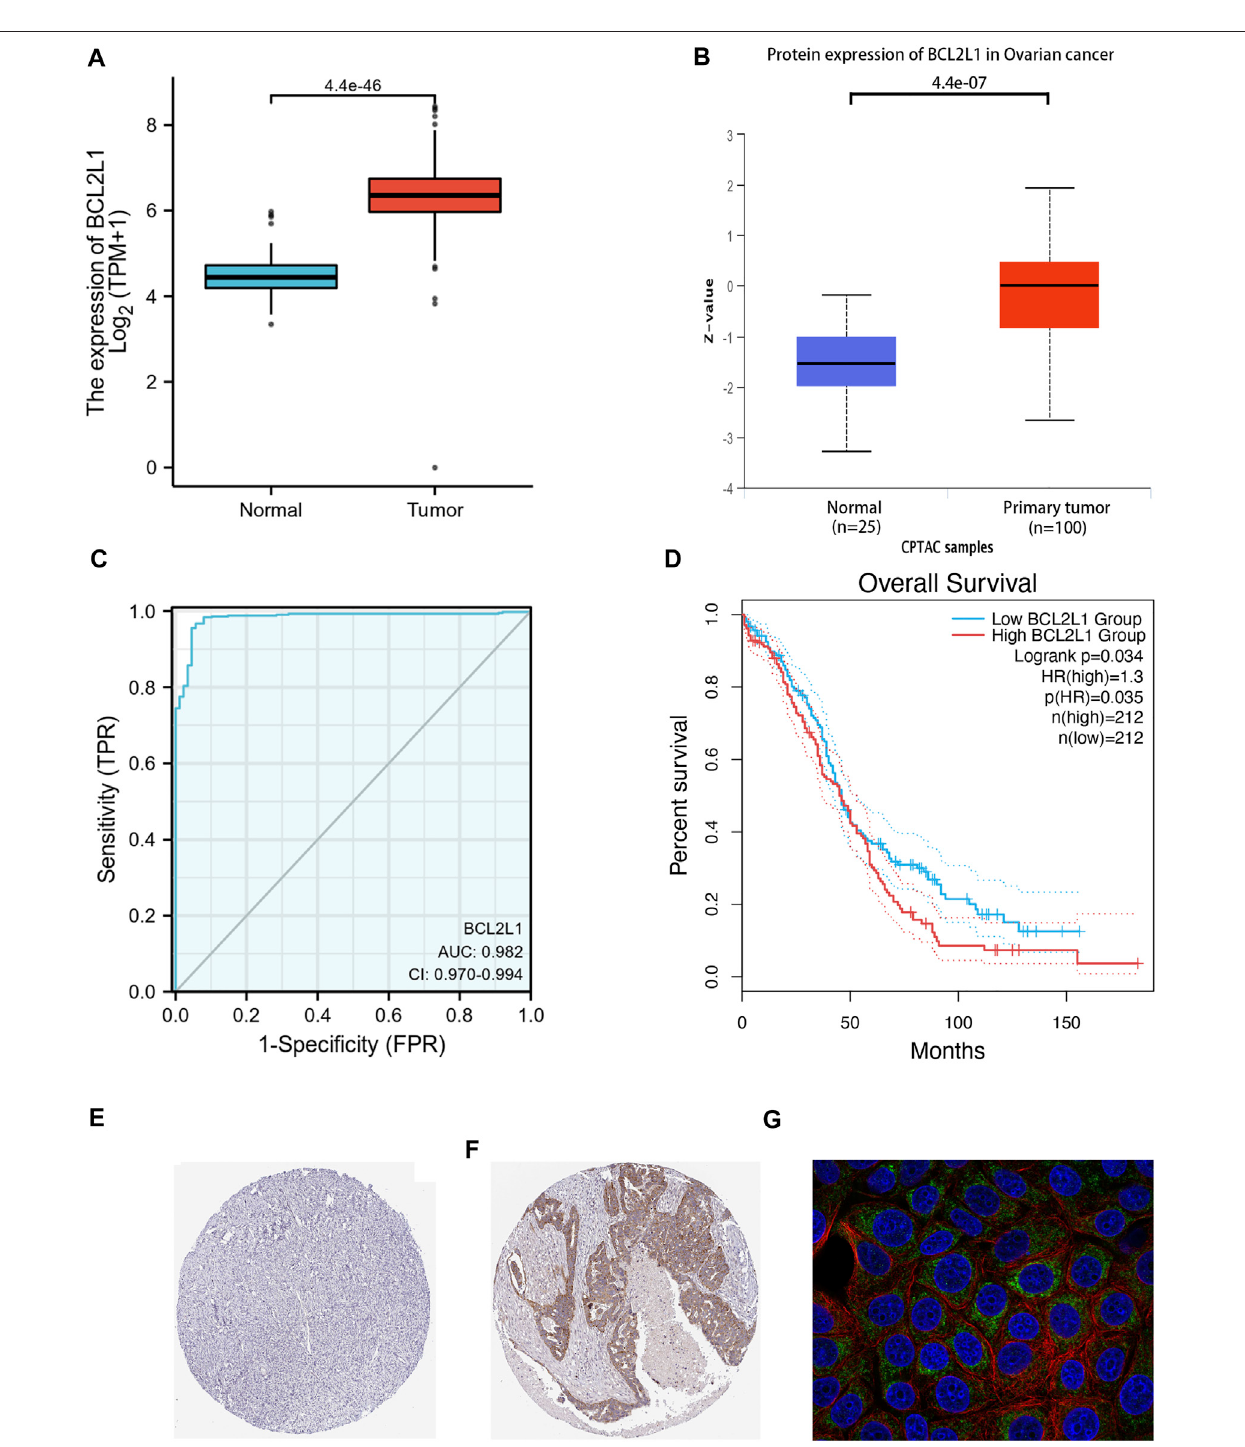
FIGURE6| BCL2L1ishighlyexpressedinOCandcorrelateswithpoorpatientprognosis. (A) Wilcoxonsignedrank-sumtestwasusedtoanalyzethedifferencein BCL2L1 expression between normal and OC samplesof OC tissues in the assay GTEx. (B) Based on the CPTAC dataset, the expression levels of total BCL2L1 protein were analyzed between normal and primary tissues of OC. (C) ROC curves showed that BCL2L1 expression levels could effectively distinguish OC tissues from non- tumortissues.The x -axisindicatesthefalsepositiverateandthe y -axisindicatesthetruepositiverate. (D) HighBCL2L1expressionwascorrelatedwithpooroverall survival prognosis in OC patients by GEPIA2 database analysis. (E – F) Human protein pro fi les showed higher BCL2L1 protein levels in OC tissues than in normal tissues (Antibody HPA035734). (G) Staining in the MCF-7 cell line revealed that BCL2L1 was localized to the mitochondria.